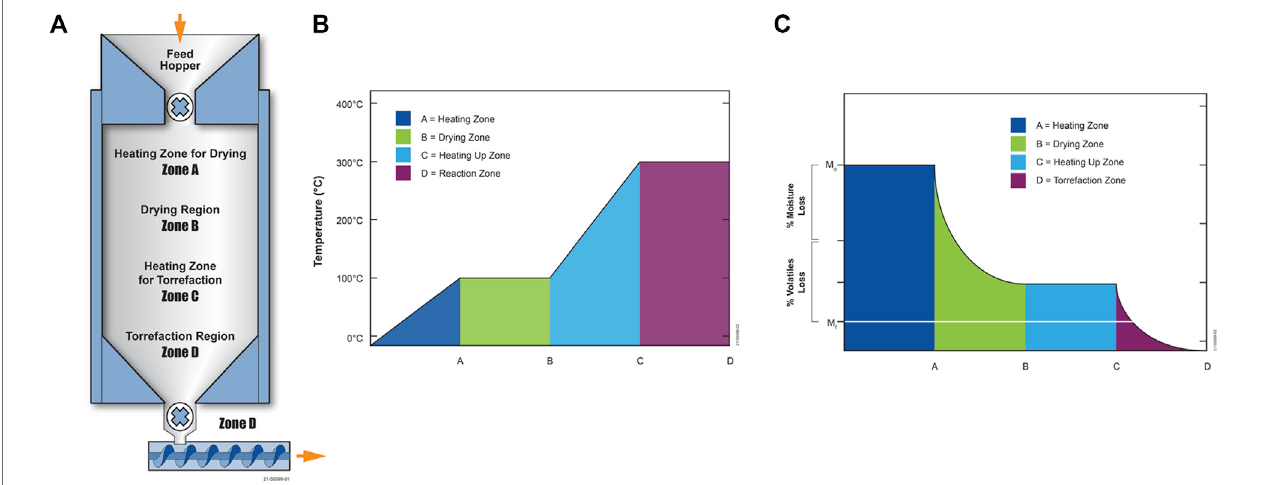
FIGURE 11 | (A) Torre fi er thermodynamic zones (B) illustration of biomass temperature pro fi le (C) biomass solid mass as it passes through the torre fi